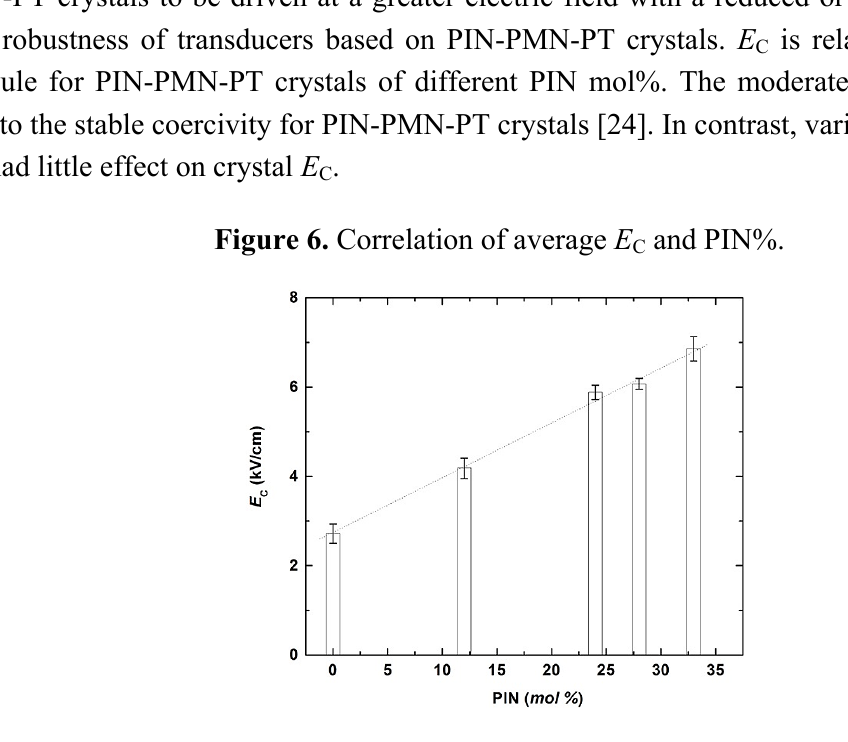
Figure 6. Correlation of average E